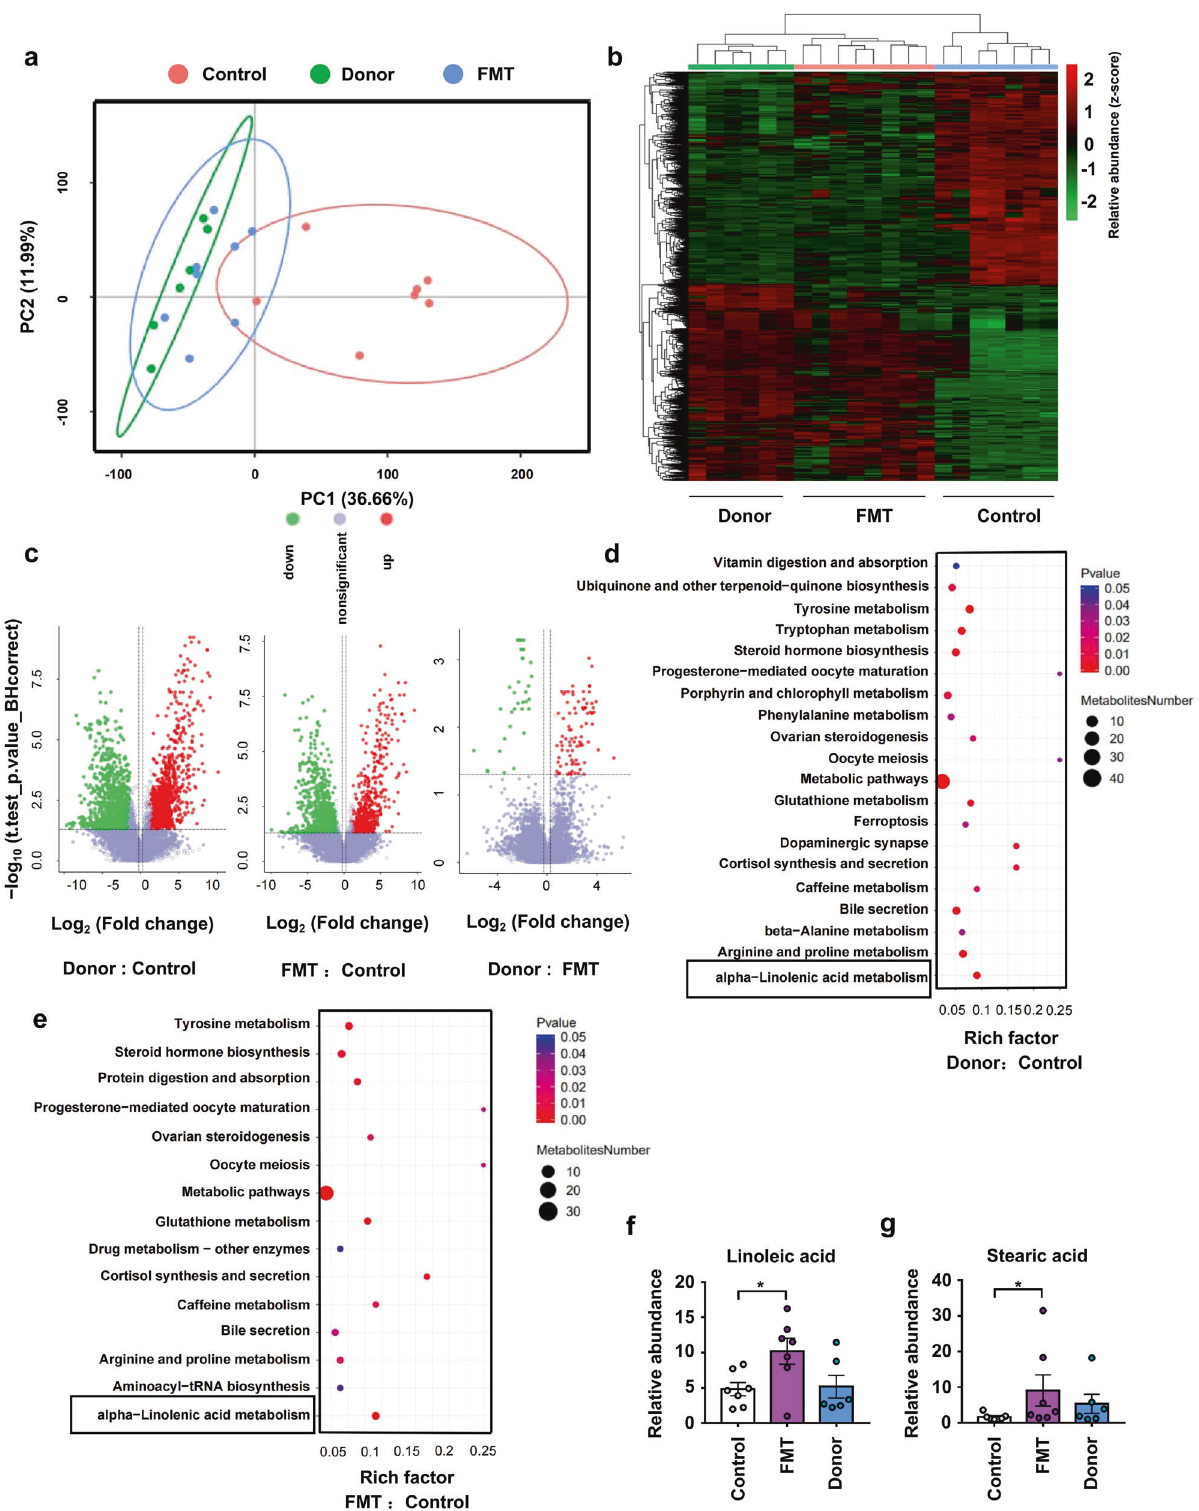
Fig. 5 Fecal microbial transplantation from donor mice altered the intestinal metabolic composition and metabolic pathways of transplanted mice. a PCA of fecal metabolites from FMT, Control, and Donor mice. b Heatmap of metabolites identi fi ed in fecal samples. c Volcano plot of metabolites identi fi ed in fecal samples. Volcano plots are depicted with the fold change of each metabolite and the q value was calculated by performing a t -test and corrected by the false discovery rate. d , e Pathway enrich analysis of metabolites from Donor and Control mice, and FMT and Control mice. f , g Relative abundance of linoleic acid and stearic acid in fecal metabolites. Data presented as mean ± SD on relevant graphs. * P ≤ 0.05; ** P ≤ 0.01; *** P ≤ 0.005 (one-way ANOVA). Control ( n = 7), FMT ( n = 7), and Donor ( n = 6)